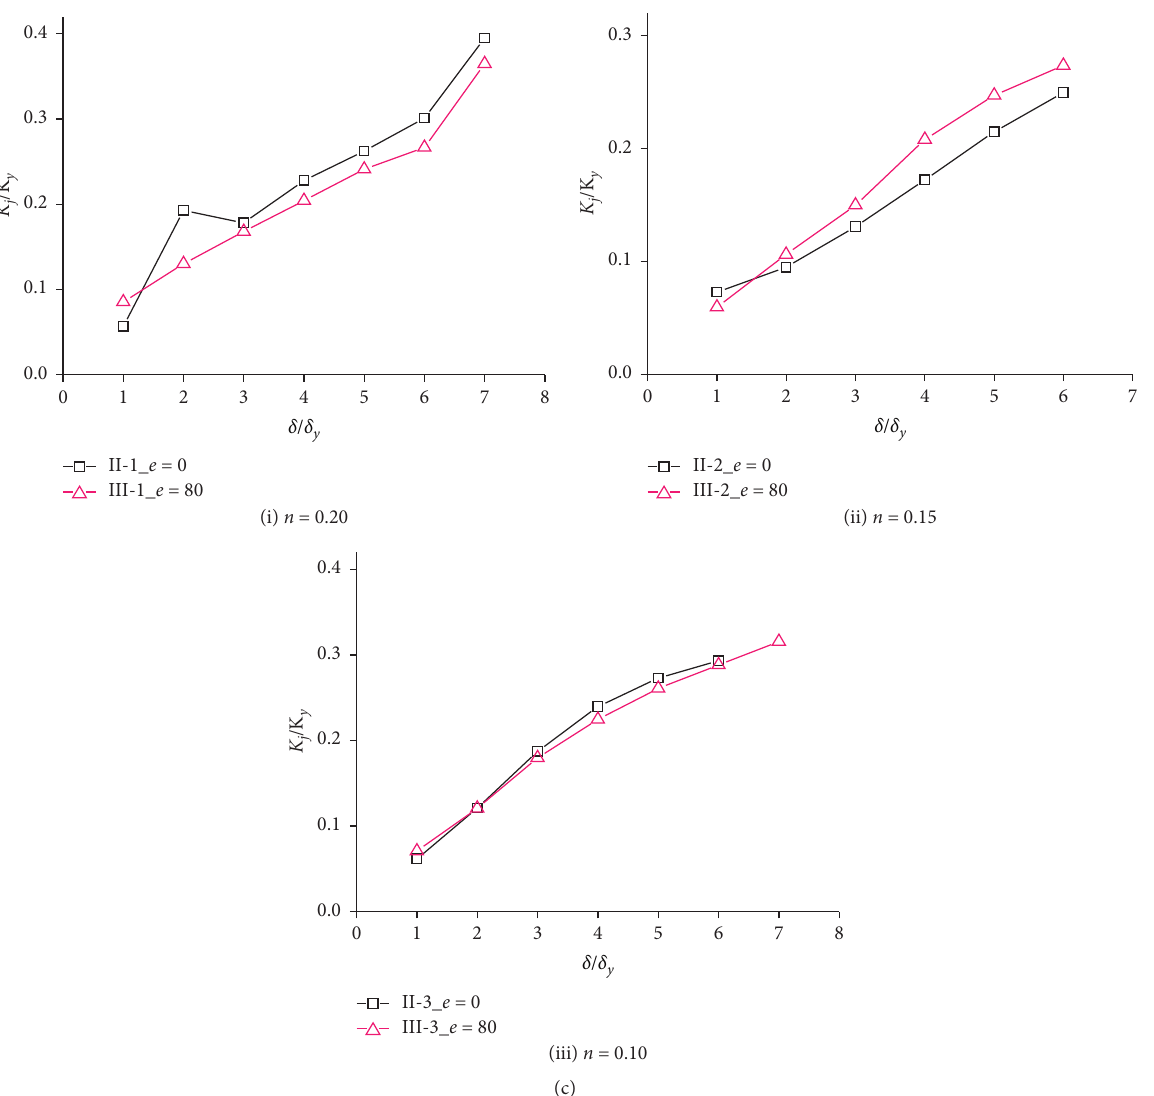
Figure 13: Equivalent viscous damping coefficient h e of the specimens. (a) Effects of installing buckling-restrained energy dissipation wall plates. (b) Effects of axial compression ratio n . (c) Effects of eccentricity e .